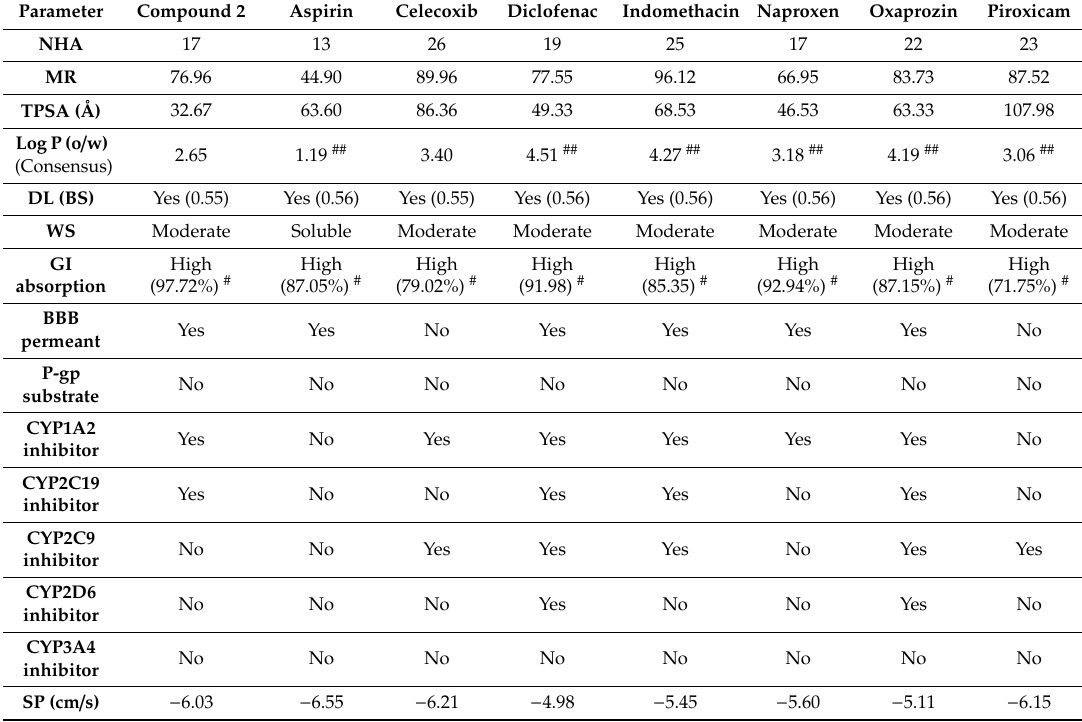
Table 2. Comparative physicochemical and ADME parameters of 2 and selected NSAIDs.